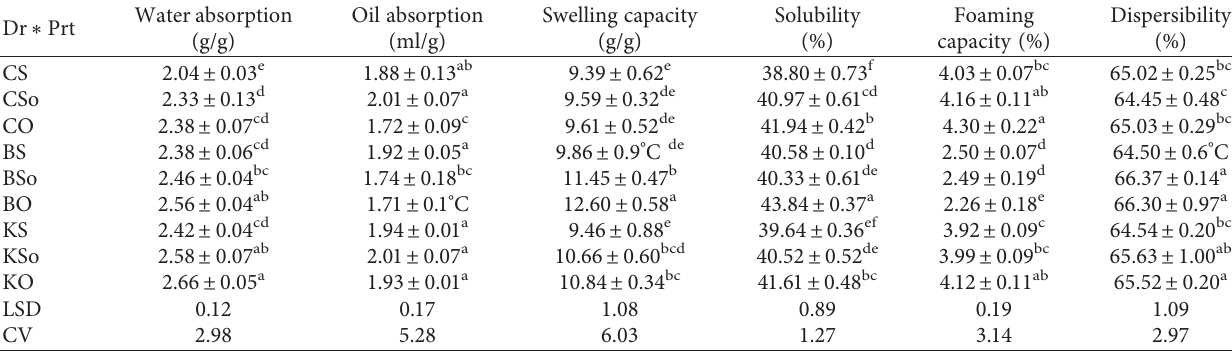
Table 4: Functional properties of anchote flour as affected by pretreatments and drying methods. Dr ∗ Prt